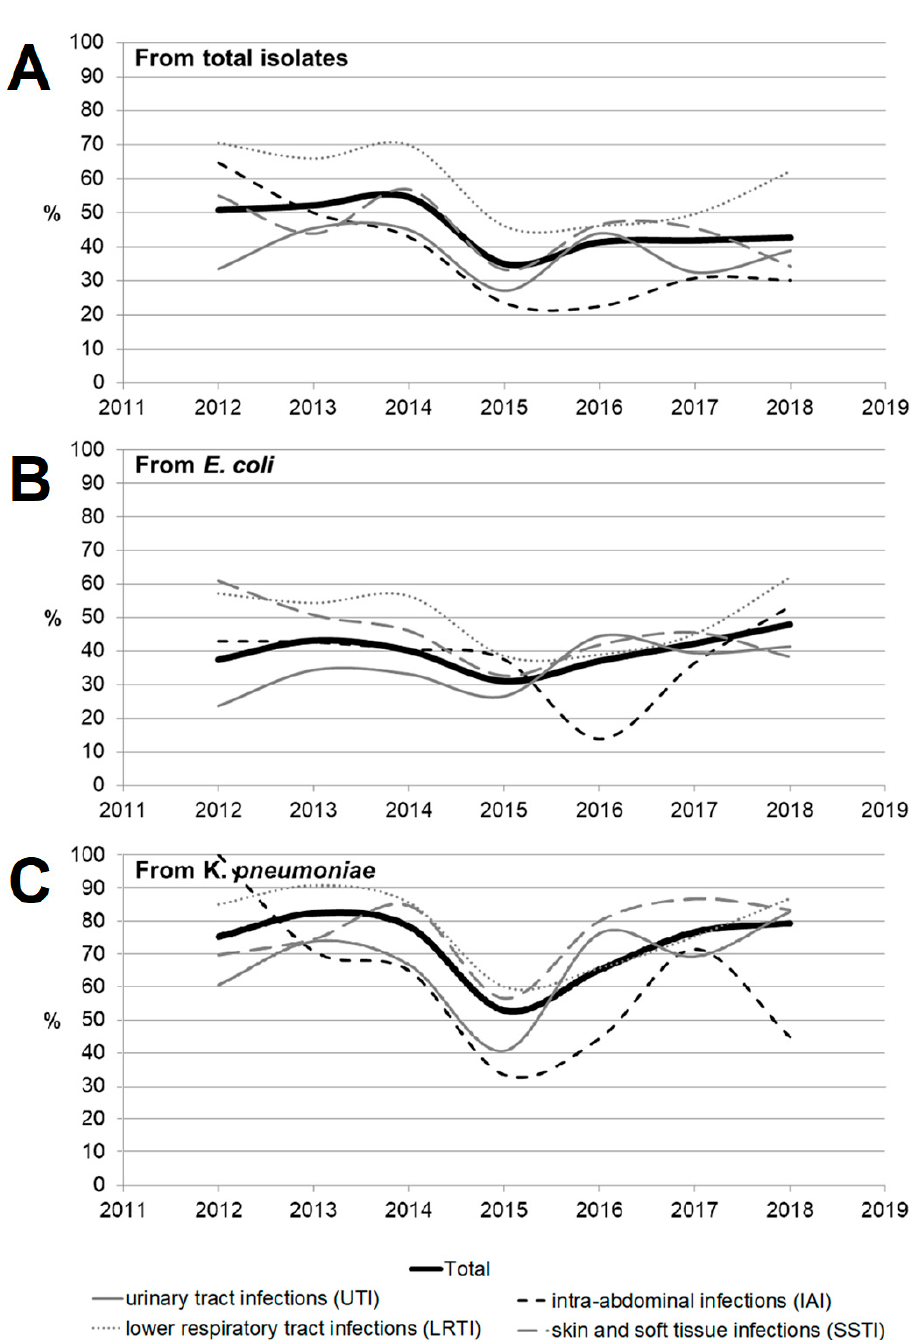
Figure 5. The dynamics of detection of ESBL-positive strains among Enterobacteriaceae isolates ( A ) depending on location of the infection source (as well as among the two most common species, Escherichia coli ( B ) and Klebsiella pneumonia ( C )).